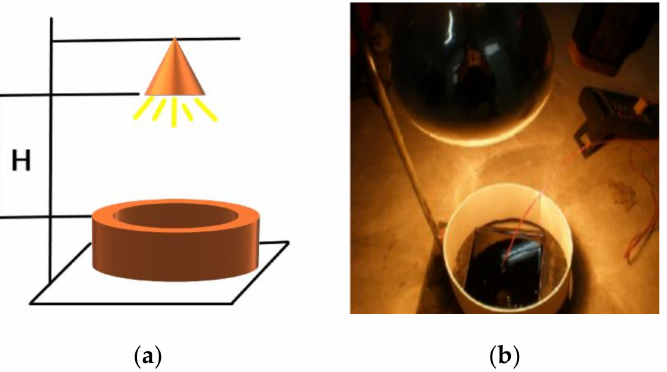
Figure 2. Asphalt slurry radiation testing device. ( a ) Schematic diagram; ( b ) Experimental